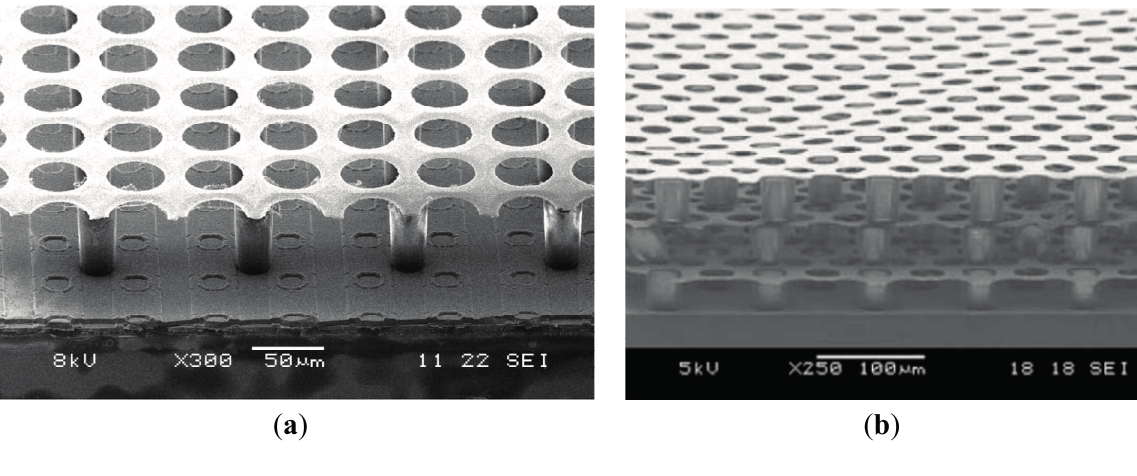
Figure 3. ( a ) SEM image of an aluminium micromesh grid suspended on top of SU-8 pillars structured in the middle of four pixels of a Medipix2 silicon pixel